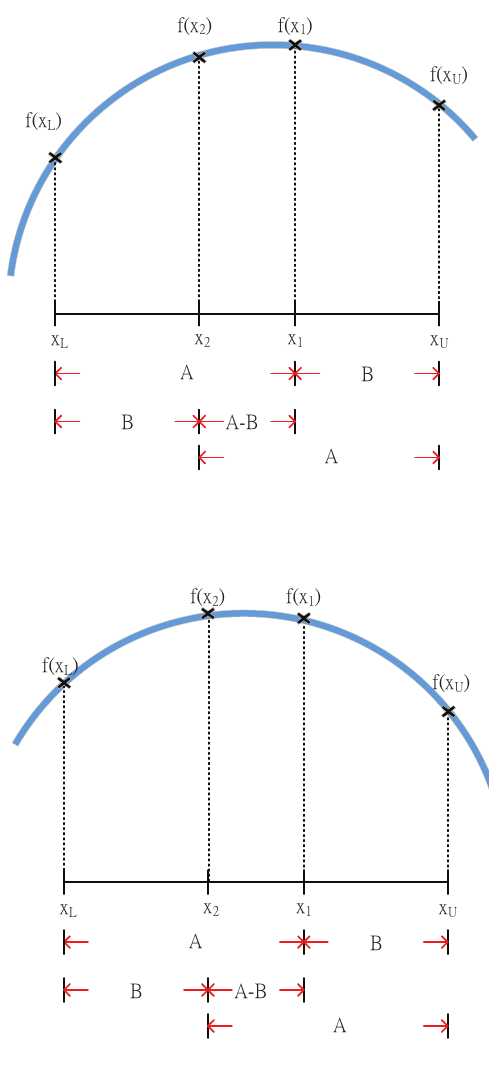
Figure 5. ( a ) upper: bounded region for f ( X 1 ) > f ( X 2 ) ; ( b ) lower: bounded region for f ( X 2 ) > f ( X 1 )